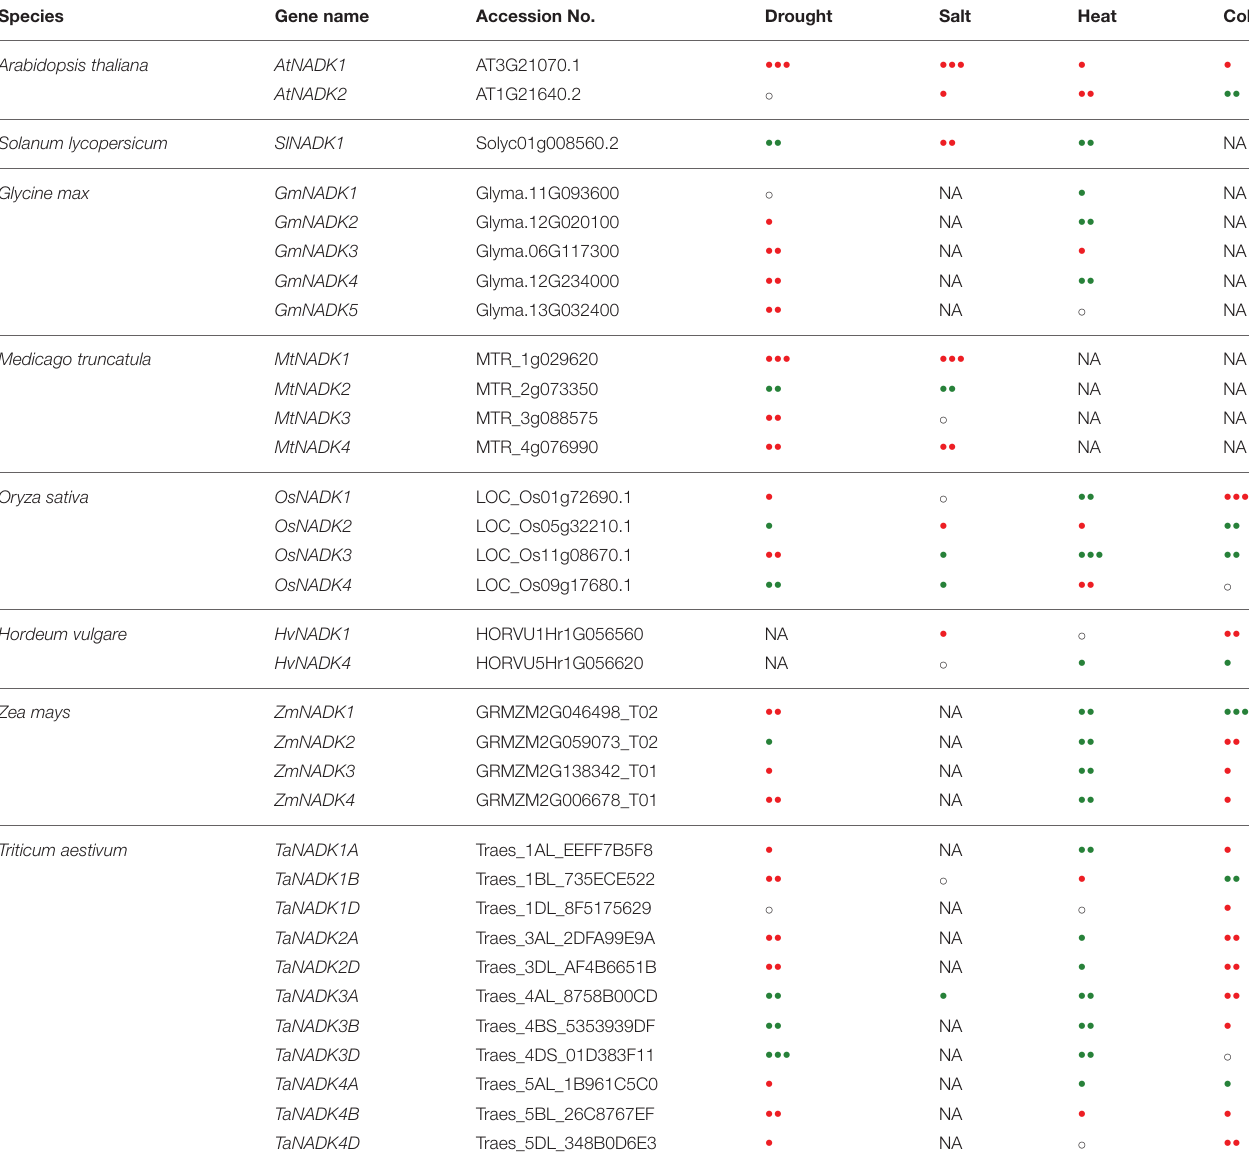
TABLE 3 | Inducible expression patterns of NADK family genes in eight plant species under drought, salt, heat, and cold stresses.